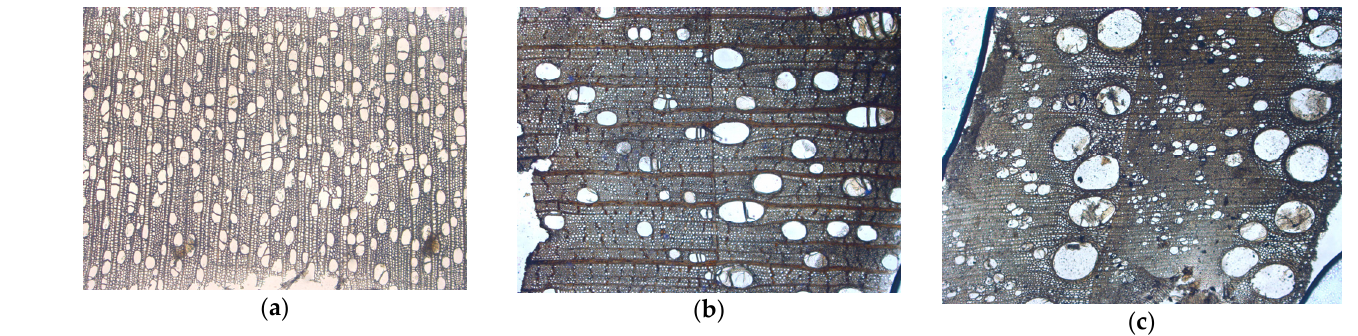
Figure 4. On the left is a type of wood with diffuse porosity (poplar), in the centre is a type of wood with semi-diffuse porosity (walnut), and on the right is a porous-ring type of wood